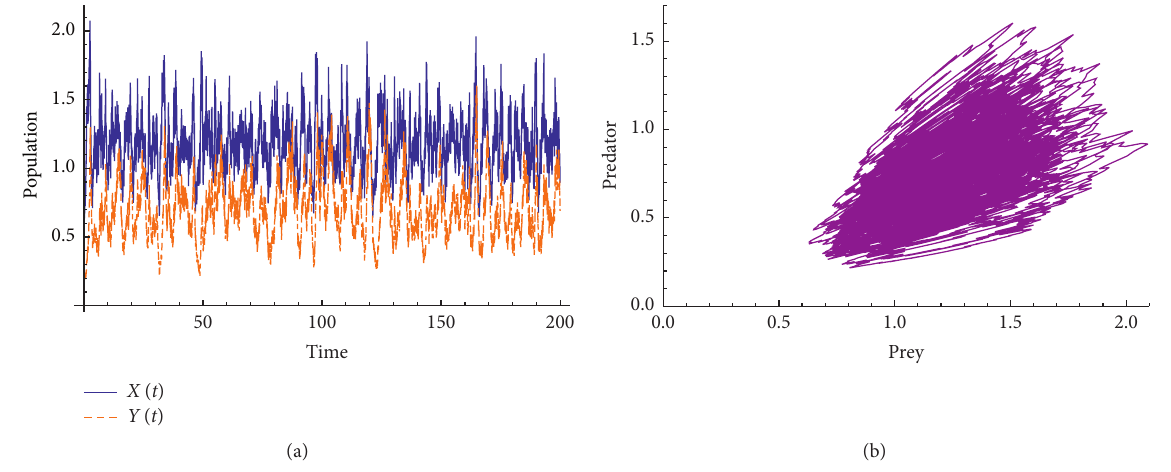
Figure 4: Dynamics model (6a) and (6b) when ( σ � 3 . 0 ) : (a) time series; (b) phase